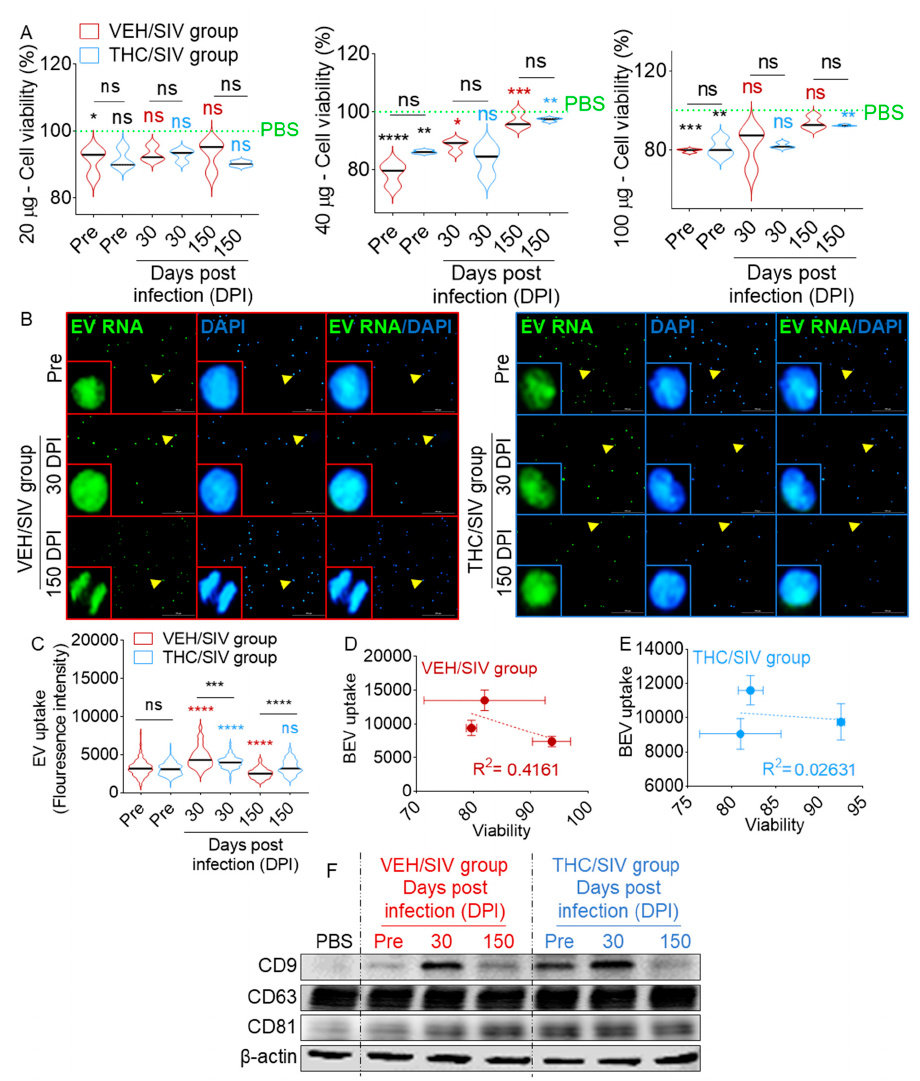
Figure 4. VEH / SIV- and THC / SIV-internalized BEVs transfer their cargo to target cells: ( A ) trypan blue exclusion assay for U937 following 18 h incubation with di ff erent concentrations (20, 40 and 100 µ g) of BEVs. Ordinary one-way ANOVA (Brown–Forsythe and Bartlett tests, with Sidak’s multiple comparisons test) was used to determine the statistical significance within the group. Binary Student’s t tests (Welch’s correction) were used to determine significant di ff erences between groups for each of the time points in each group. ( B ) Images of U937 cells incubated with SYTO RNASelect-stained BEVs (100 µ g) for 18 h. DAPI is blue and SYTO RNASelect, which stained BEV RNA, is in green. Fluorescence images were manually obtained with Lionheart FX automated microscope at 10 × magnification. Yellow arrows correspond to the enlarged area (inset). Scale bar: 50 µ m. ( C ) Quantification of BEV internalization e ffi cacy by U937 cells. Five fields of view were analyzed per time point. Ordinary one-way ANOVA (Brown–Forsythe and Bartlett tests, with Sidak’s multiple comparisons test) was used to determine the statistical significance within the group. Binary Student’s t tests (Welch’s correction) were used to determine significant di ff erences between groups for each of the time points in each group. * p < 0.05, ** p < 0.01, *** p < 0.005, **** p < 0.001, and ns = non-significant. ( D , E ) Correlation analysis between cell viability and BEV internalization. ( F ) Western blot analysis of tetraspanins in U937 cells treated with VEH / SIV and THC / SIV BEVs; β -actin was used as a loading